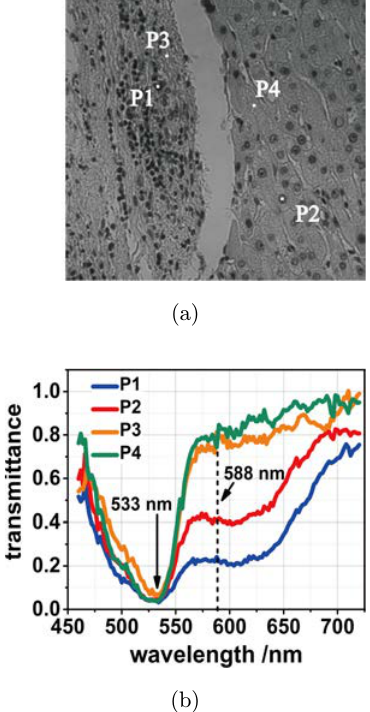
Fig. 6. (a) Points in cancer cell (P1), normal cell (P2), interstitial area in cancer nest (P3), and interstitial area in normal tissue (P4). (b) Transmission spectra at P1, P2, P3, and P4.